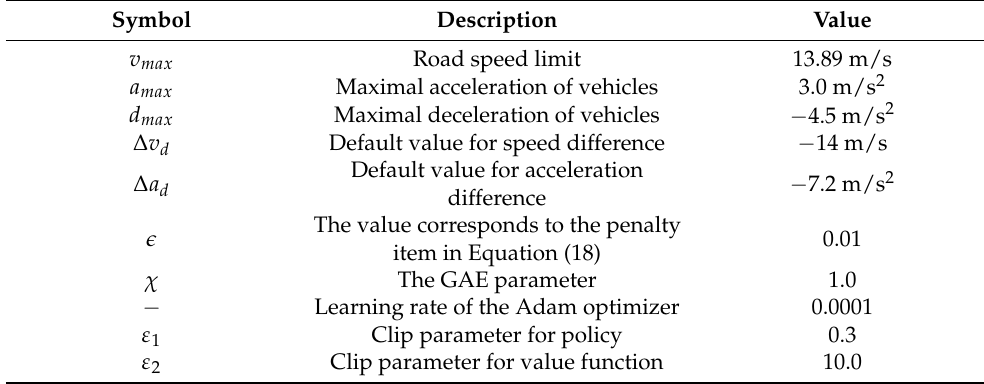
Table 1. General parameter settings for